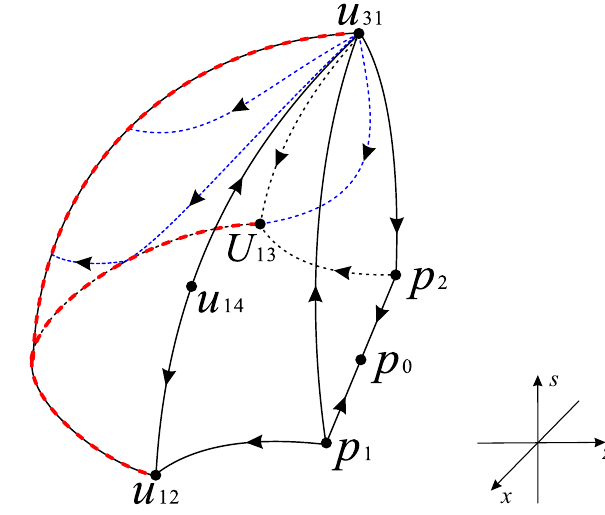
Fig. 9 Phase portrait in the back boundary of the region R 1